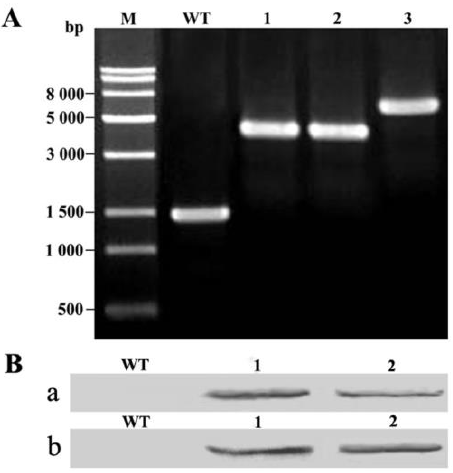
Figure 2. PCR and immunoblot analysis of wild-type Synechocystis and thioesterase transformants. ( A ): PCR analysis of transgenic Synechocystis in which a fragment of psbA2 was deleted and replaced with various exogenous genes. M: Trans15k DNA Marker; WT: wild type Syenchocystis sp. PCC6803; Lane 1: pSD FatA ; Lane 2: pSD FatB ; Lane 3: pSD FatAB ; ( B ): Immunoblot analysis of Synechocystis wild type and thioesterase transformants grown at 30 °C under mixotrophic conditions. a: Immunoblot analysis using His-tag antibodies. WT: wild type Synechocystis sp. PCC6803; Lane 1: pSD FatA Synechocystis transformant; Lane2: pSD FatAB Synechocystis transformant; b: Immunoblot analysis using Flag-tag antibodies. WT: wild type Synechocystis sp. PCC6803; Lane 1: pSD FatB Synechocystis transformant; Lane 2: pSD FatAB Synechocystis transformant. To detect the expression of AhFatA or AhFatB in the transformants, we incubated the wild-type and SD FatA /SD FatB /SD FatAB transformant cells at 30 °C. Immunoblot analysis confirmed the